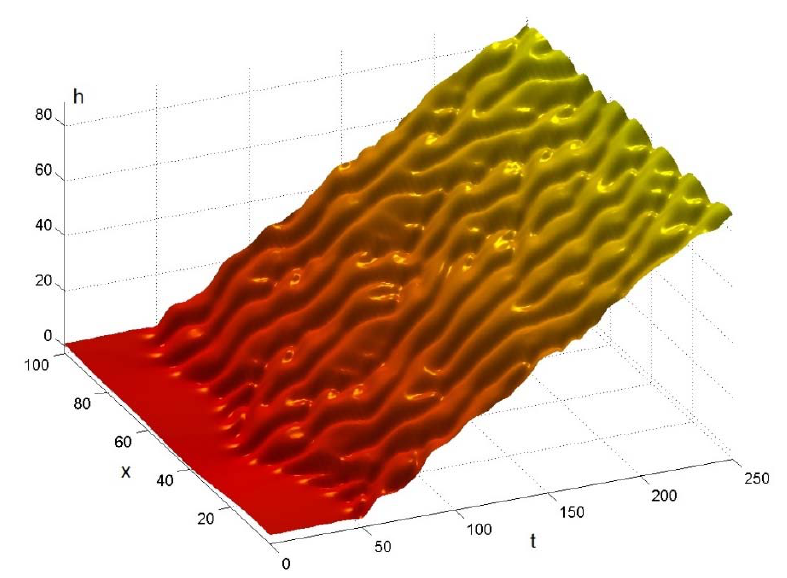
Figure 1. The height profile h ( t , x ) from solution of Equation (5) with r = 0.01.